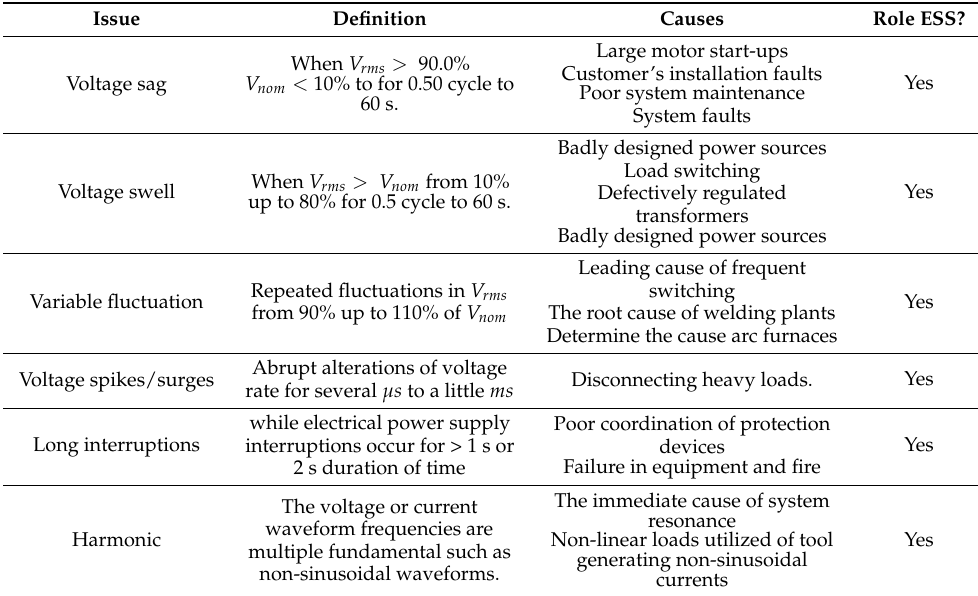
Table 2. The most common power quality issues in DNS [39–43].